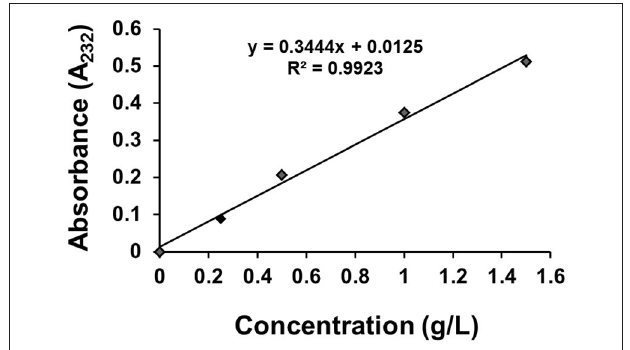
FIGURE 2 | The standard curve of